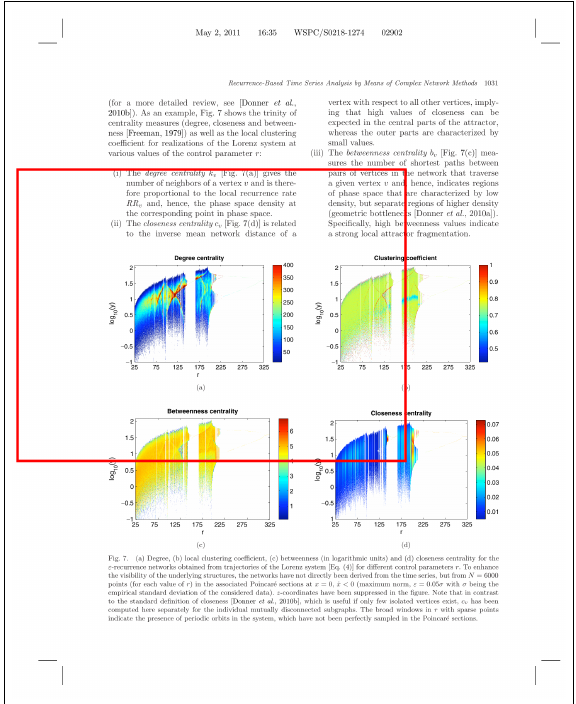
Figure 5. One of the cases where the labels in CS-Large were obviously wrong and had to be corrected. These cases seem to be due to wrong scaling. However, they occur in multiple documents with a different scaling factor every time. The annotations do contain a “dpi” attribute, but applying scaling based on this attribute was not helpful for these